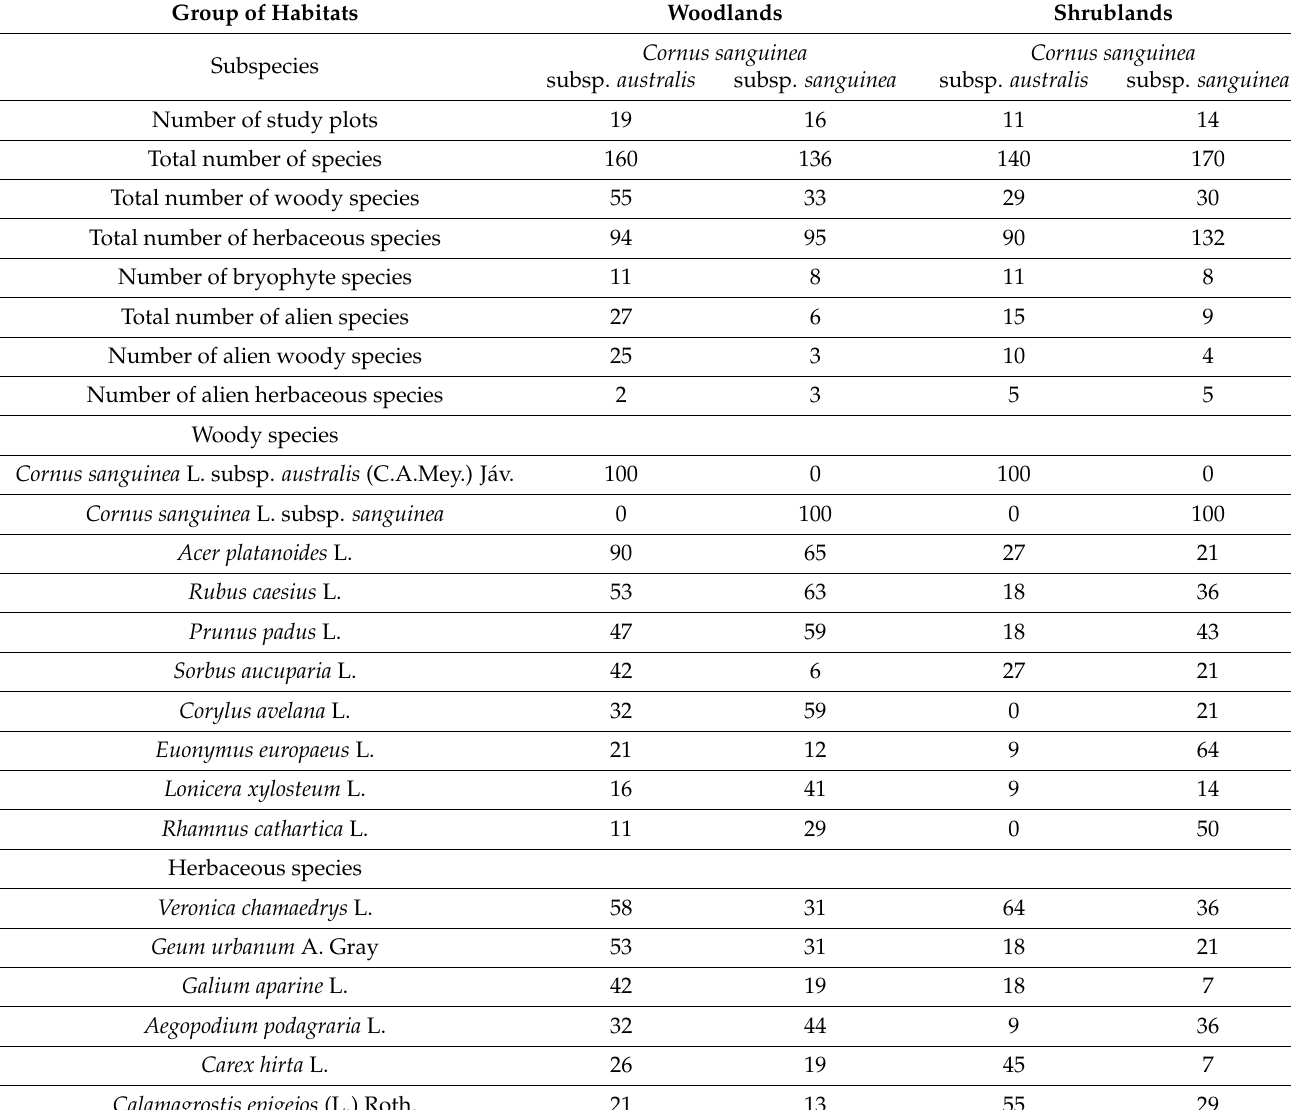
Table 5. The number of plant species and their frequency (%) in the study plots of plant communities with Cornus sanguinea subsp. australis and Cornus sanguinea subsp. sanguinea . The table includes species with a frequency of more than 40% in at least one group of the study plots. Group of Habitats Woodlands Shrublands Cornus sanguinea Cornus sanguinea Subspecies subsp. australis subsp. sanguinea subsp. australis subsp.